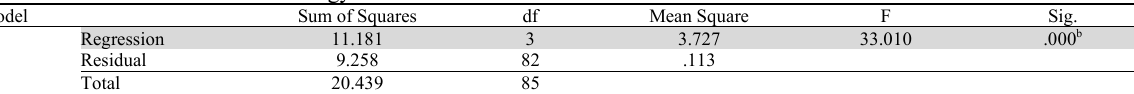
F test results of information technology Model Sum of Squares